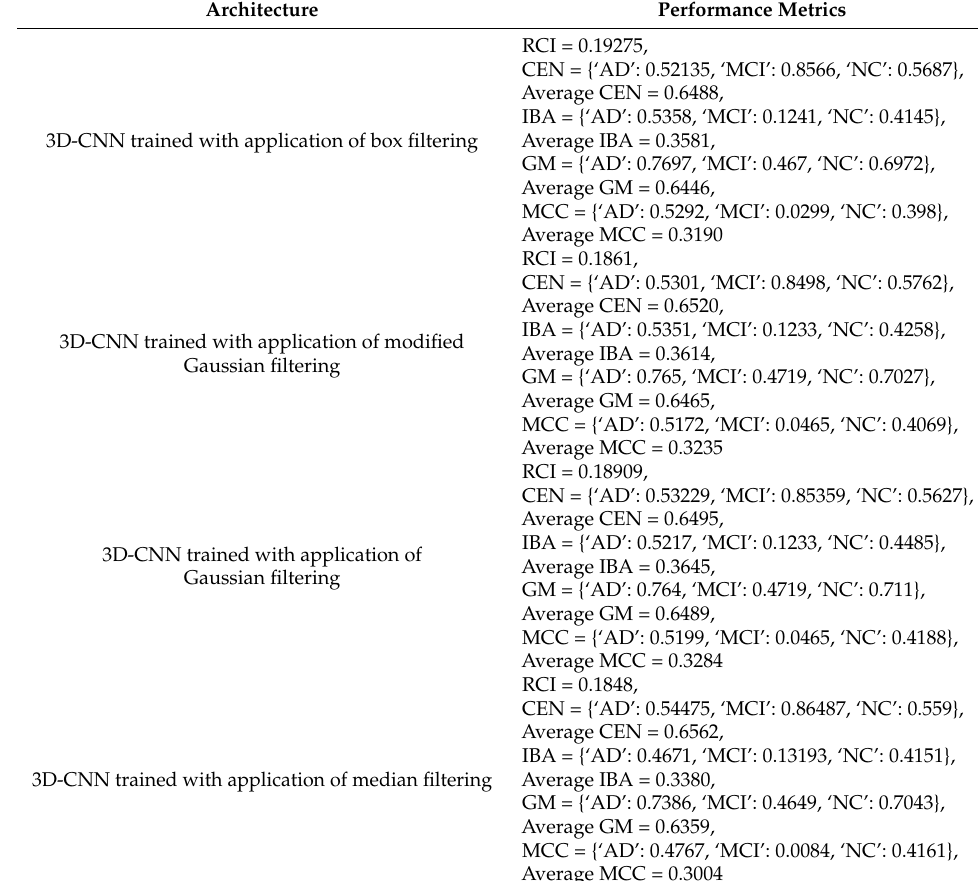
Table 2. Result of multiclass classification between AD, NC, and MCI classes.